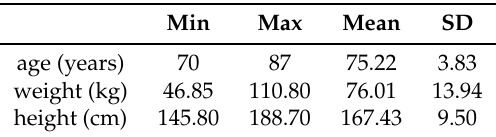
Table 2. Characteristics of our included study population ( n = 148) with minimum (min), maximum (max) and mean-value (mean), as well as the standard deviation (SD) of age in years, body weight in kg and body height in